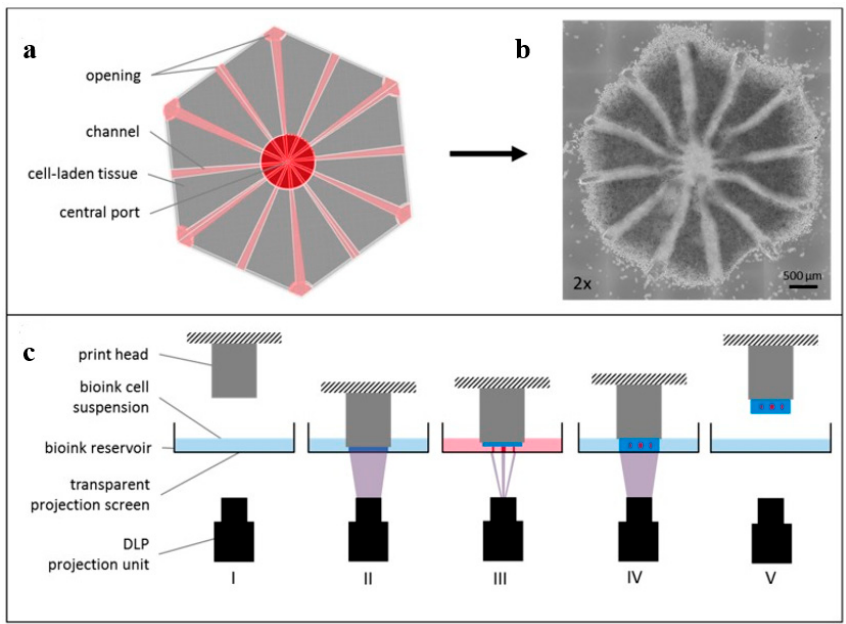
Figure 37. Cell brick 3D printing process of liver: ( a ) virtual 3D design; ( b ) microscopic image of the printed multi-material cell-laden hydrogel; ( c ) multi-material DLP 3D printing setup used for liver design printing. Reproduced from [329].